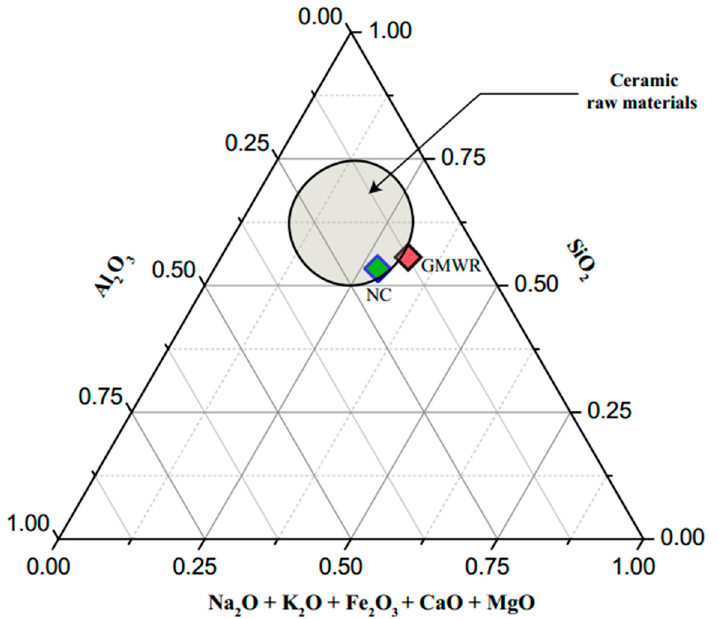
Figure 5. Representation of the studied samples in the ternary diagram of SiO 2 –Al 2 O 3 –fluxing oxides showing the zone of suitable materials for fired bricks based on [48].